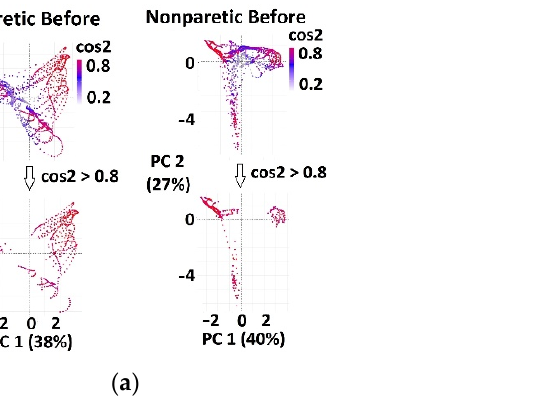
Figure 7. Examples of overlapped cyclograms for one patient ( top ) and thresholded cyclograms ( bottom ). Extracted (red) observations on thresholded cyclograms correspond to temporal synergies in PCA space: ( a ) before therapy (the paretic leg is in the left column, the nonparetic leg is in right column), and ( b ) after therapy (the paretic leg is in the left column and the nonparetic leg is in right column). In brackets, the percentages of explained variance of the specific principal component (PC 1 or PC 2 ) are shown.